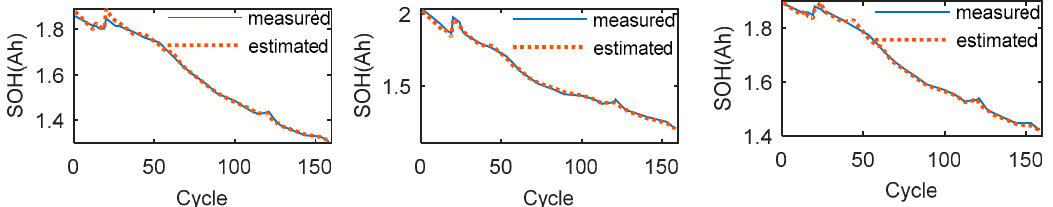
Figure 8. The SOH estimation results of the LS-SVM model with the RBF kernel tested on the No.5, No.6 and No.7 batteries.